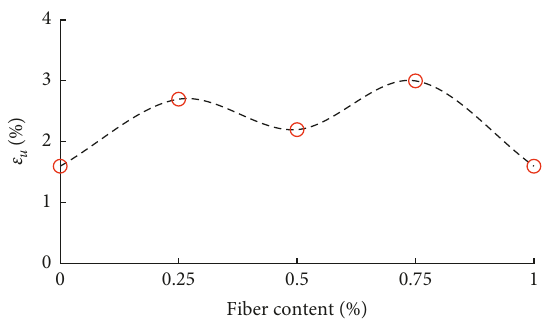
Figure 16: Failure strain ε u of slurry with various fiber